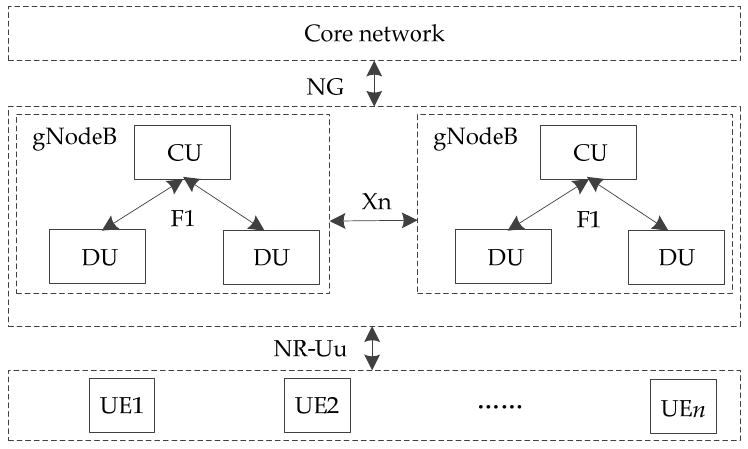
Figure 3. Interfaces between elements in 5G-R for HSRs.